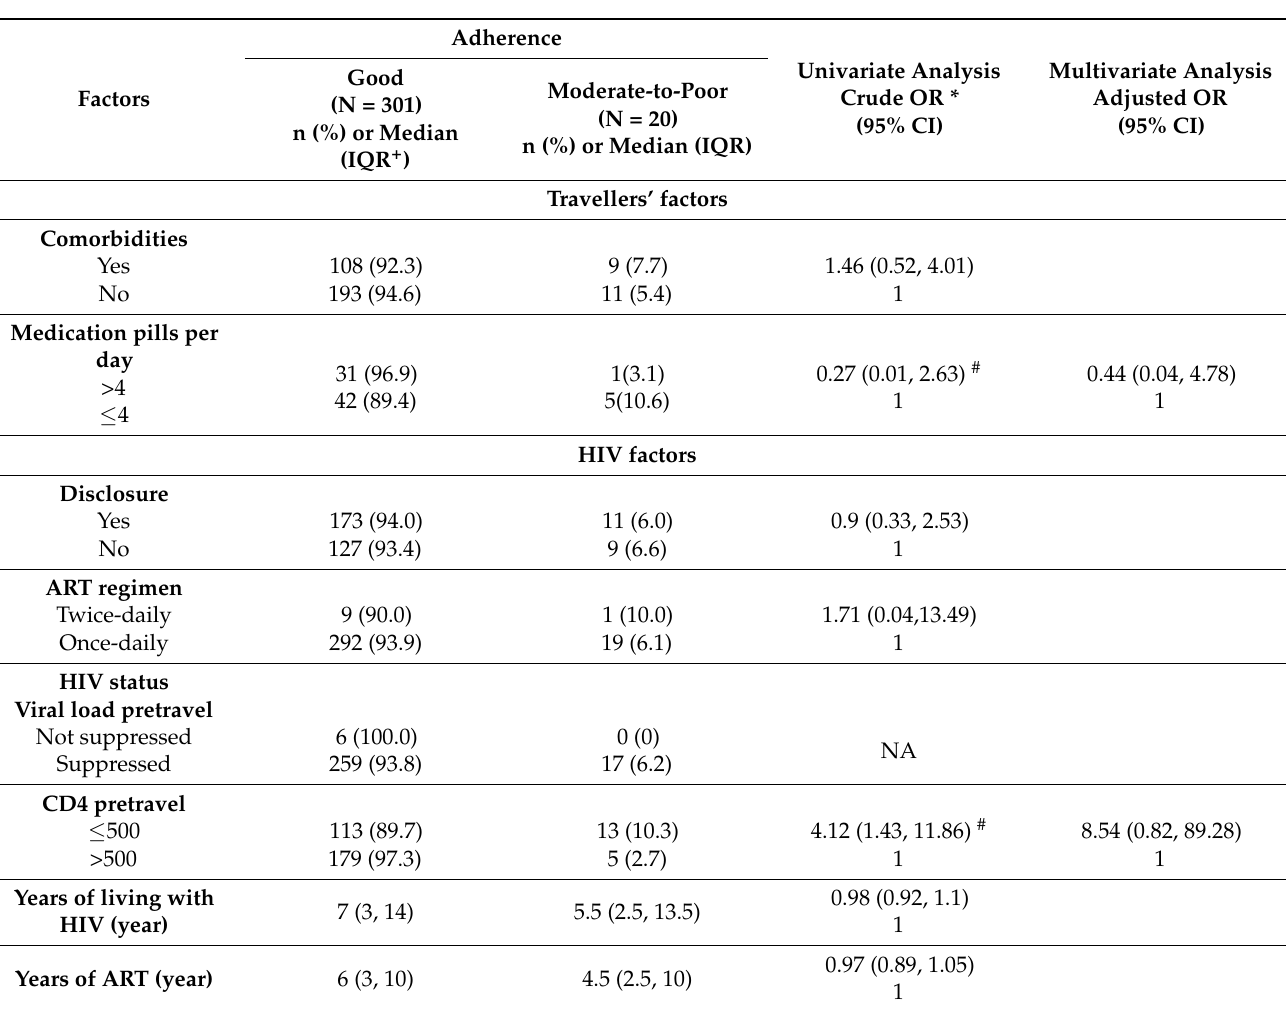
Table 2. Factors associated with moderate-to-poor adherence in Thai travellers living with HIV: univariate and multivariate logistic regression